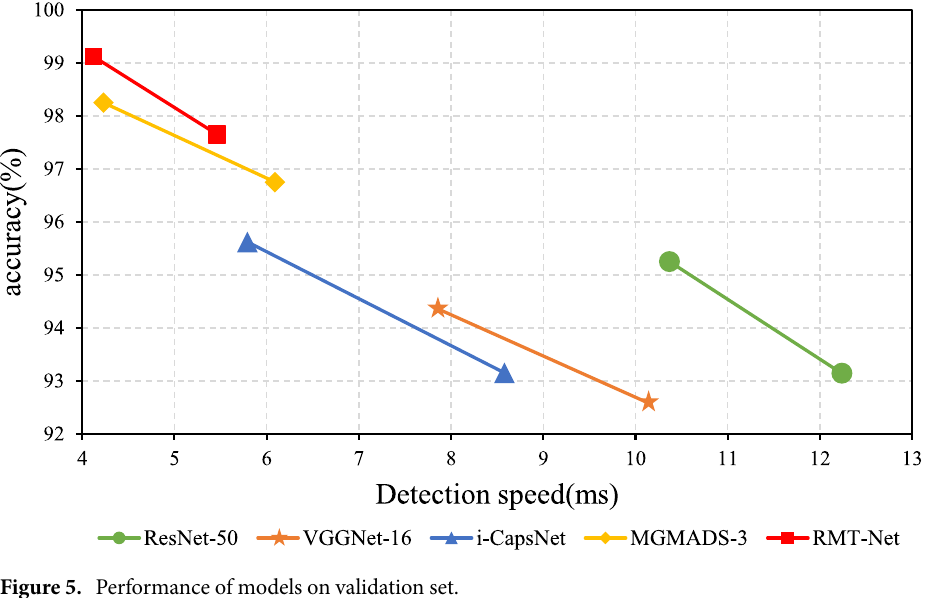
Figure 5. Performance of models on validation